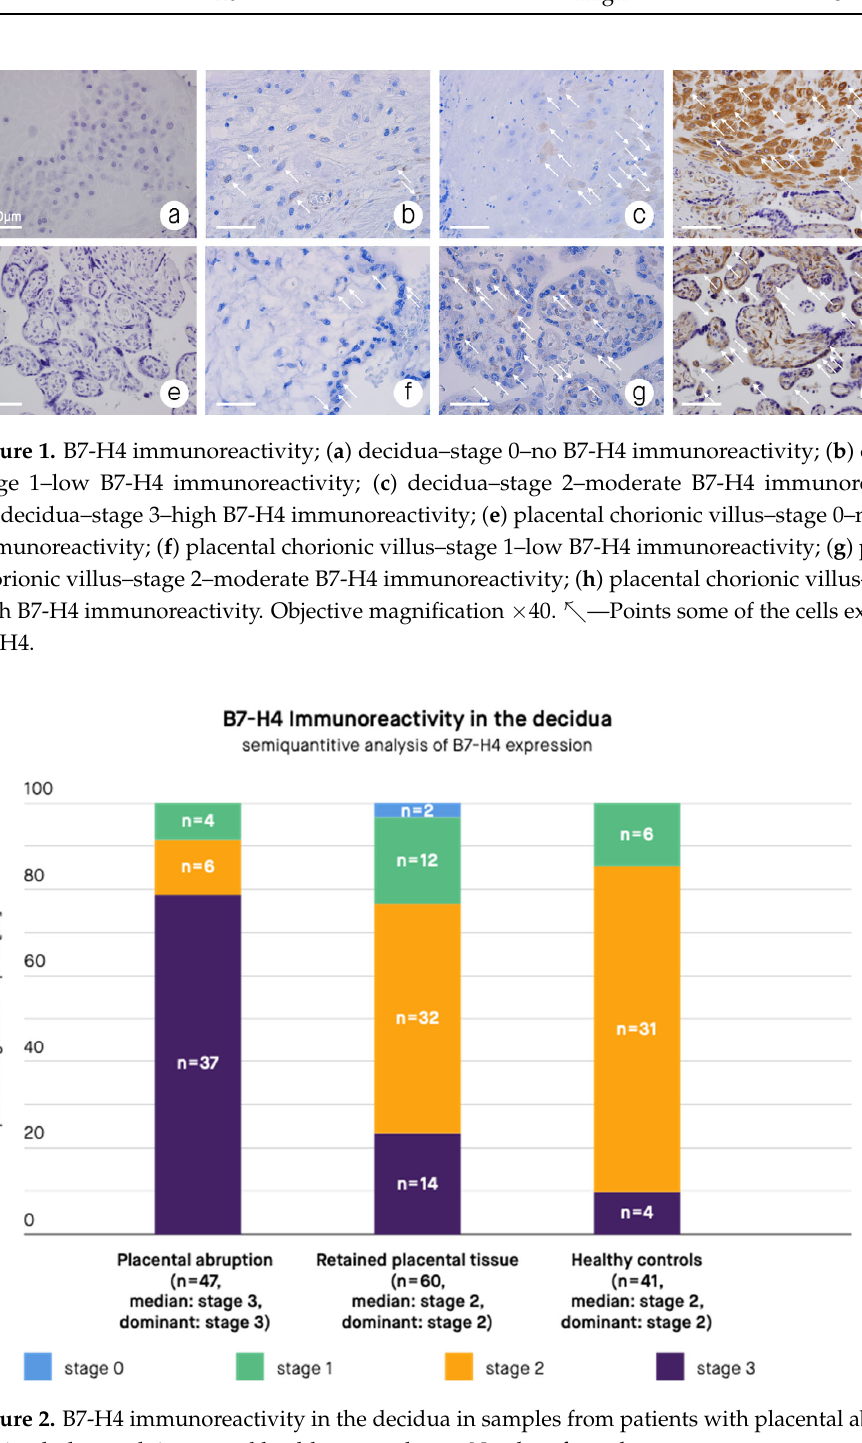
Figure 3. B7 ‐ H4 immunoreactivity in the placental chorionic villus in samples from patients with placental abruption, retained placental tissue, and healthy controls. n—Number of samples.